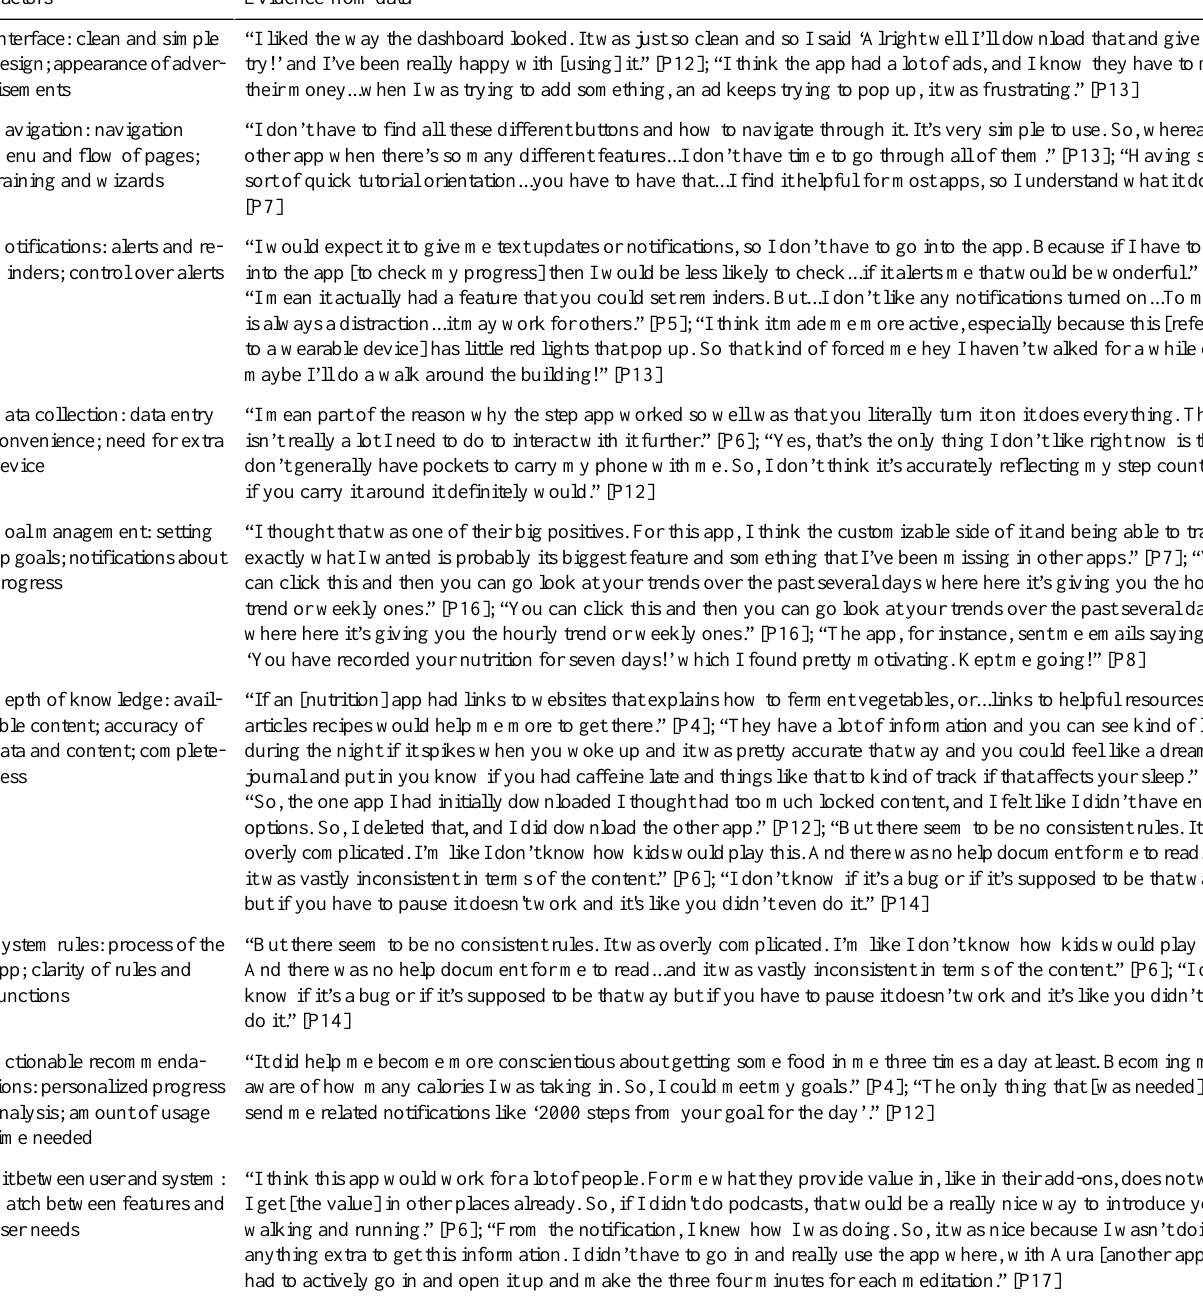
Table 2. Factors influencing decision to continue use. Evidence from